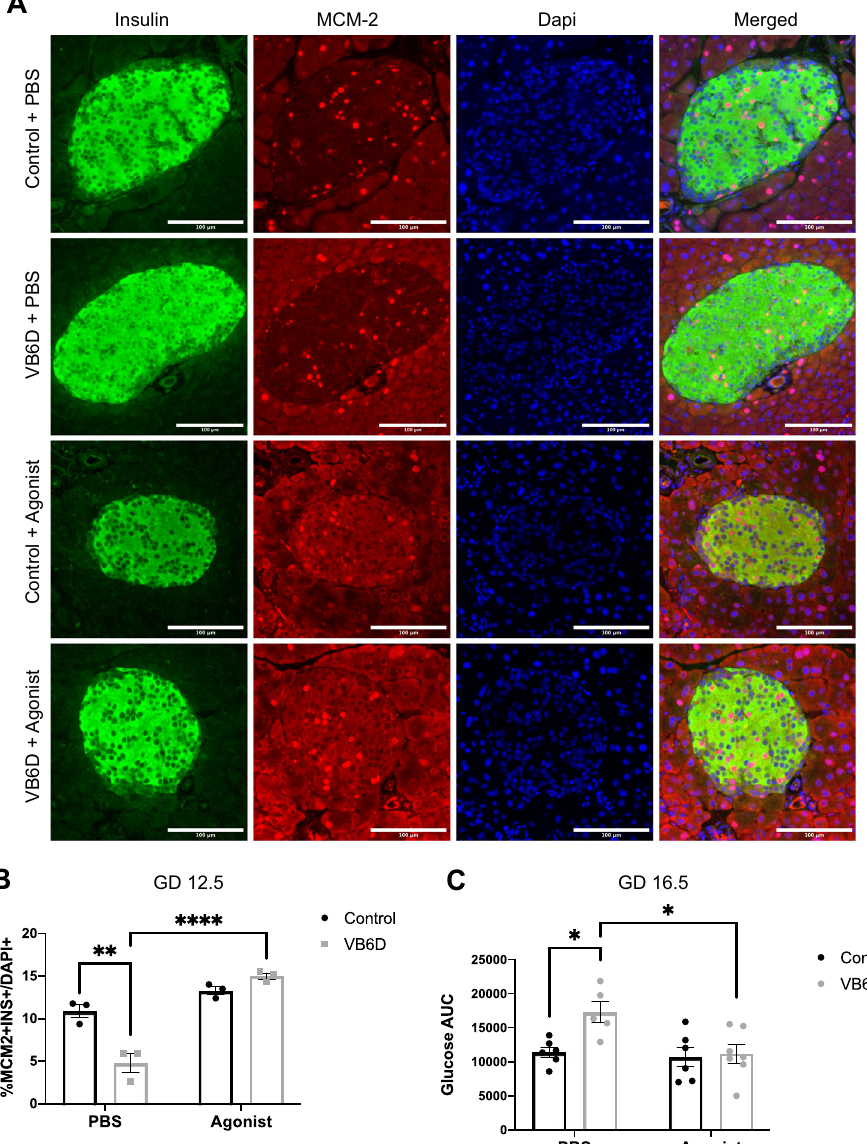
Fig. 4 HTR2B receptor agonist treatment increases β -cell proliferation in vitamin B6-de fi cient dams and normalizes glucose tolerance at GD 16.5. Shown in ( A ) is representative ×20 immuno fl uorescent images of GD 12.5 pancreases from PBS and HTR2B agonist injected control and vitamin B6- de fi cient (VB6D) mice. Proliferating β -cells are identi fi ed using MCM-2 and Insulin antibodies and calculated as percentage of total β -cells ( B ). Glucose AUC for PBS and HTR2B agonist-treated control and VB6D dams at GD 16.5 is shown in ( C ). Data for panels A and B are based on 40 – 50 islets per mouse ( N = 3 mice), while panel C represents 5 – 7 mice. Two-way ANOVA tests performed in panels B and C revealed a diet × treatment interaction effect and post hoc Tukey ’ s multiple comparison tests were subsequently performed. * p ≤ 0.05, ** p < 0.01, **** p <